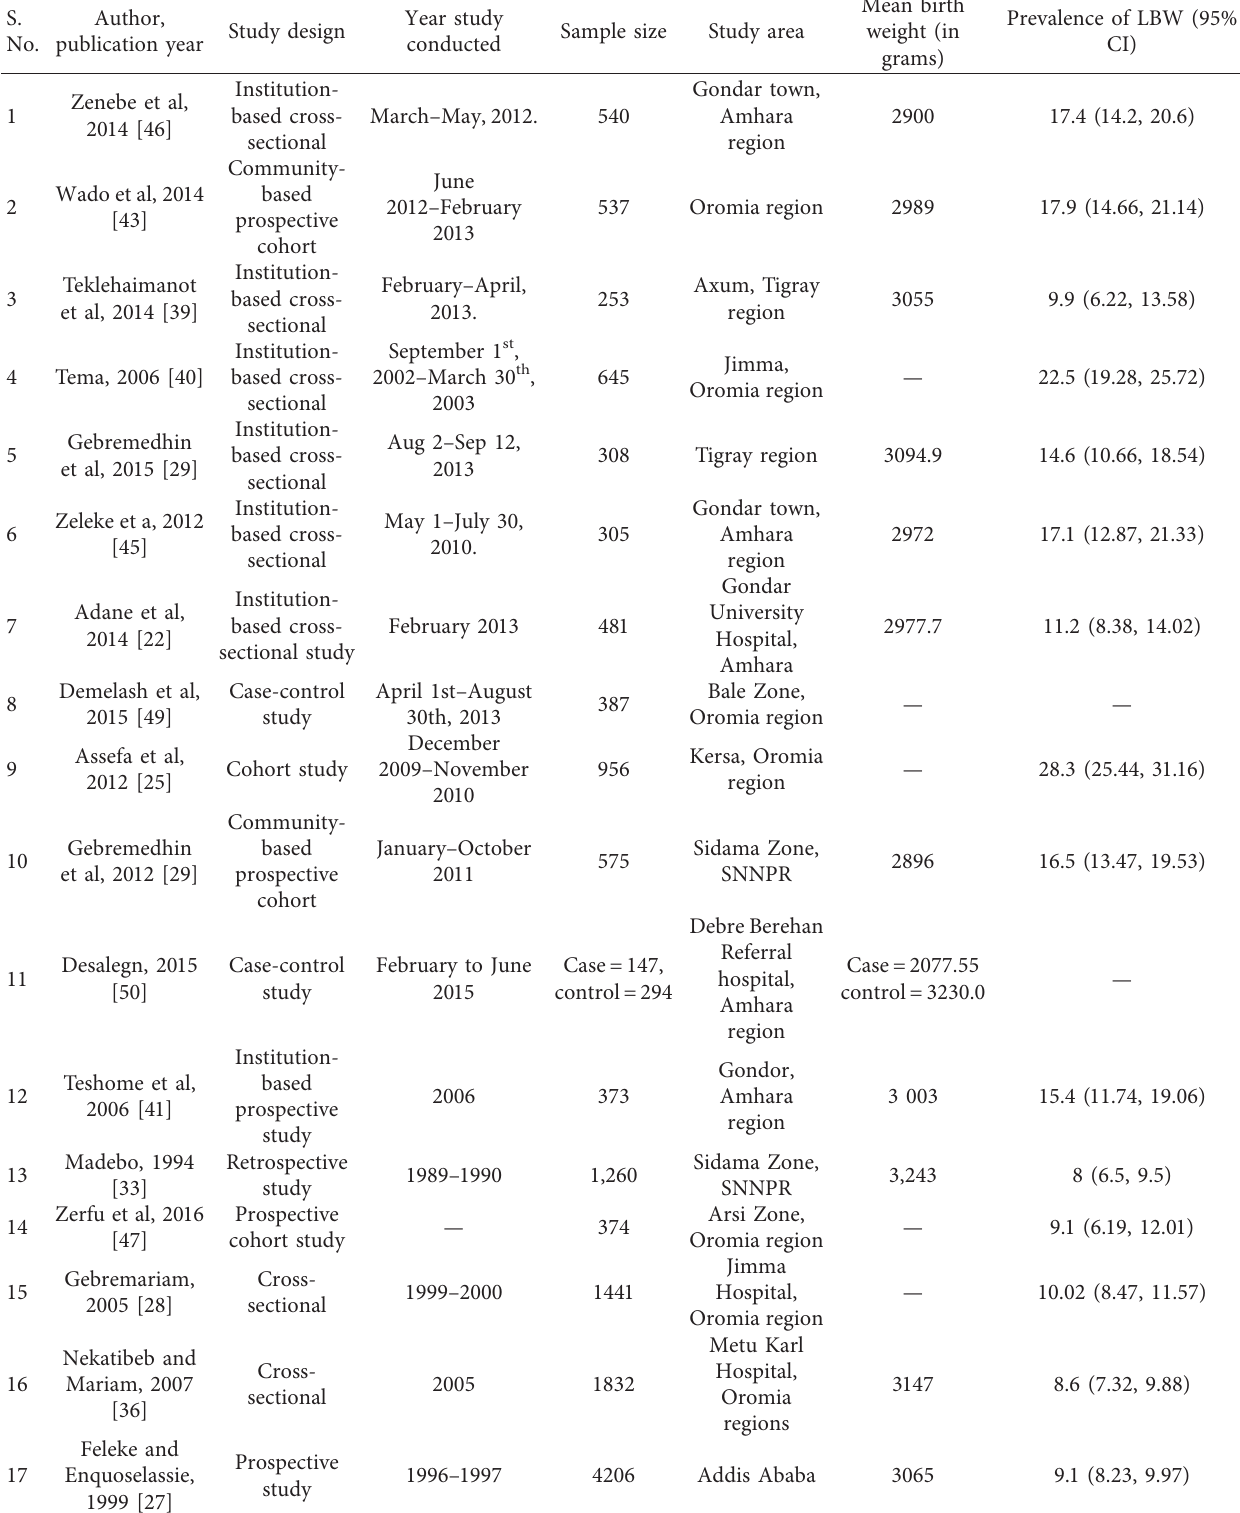
Table 1: Summary characteristics of studies included in the meta-analysis to show the prevalence of low birth weight in Ethiopia.